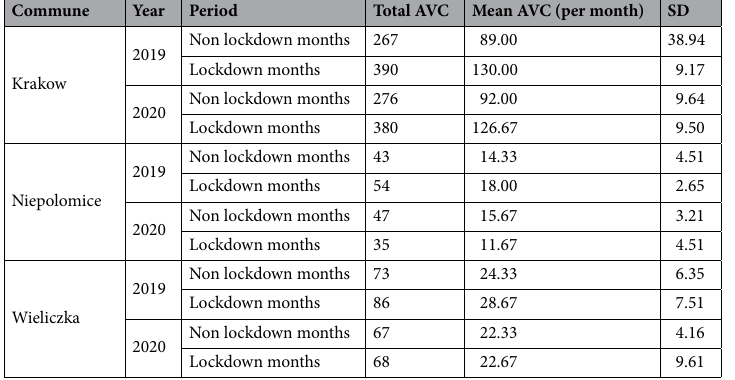
Table 1. The total and mean (± SD) animal-vehicle collision (AVC) number during non-lockdown (January, February and June) and lockdown periods (March, April and May) recorded in the study area. SD-Standard